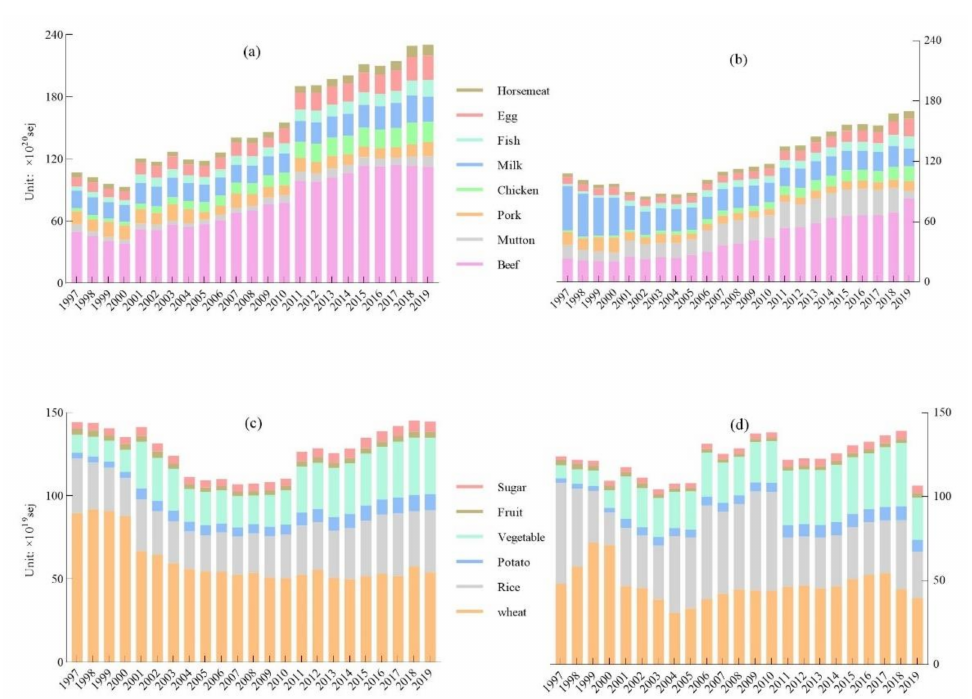
Figure A1. Annual animal-based and plant-based food consumption of urban and rural residents. ( a ) Annual animal-based food consumption of urban residents; ( b ) annual animal-based consumption of rural residents; ( c ) annual plant-based food consumption of urban residents; ( d ) annual plant-based food consumption of rural